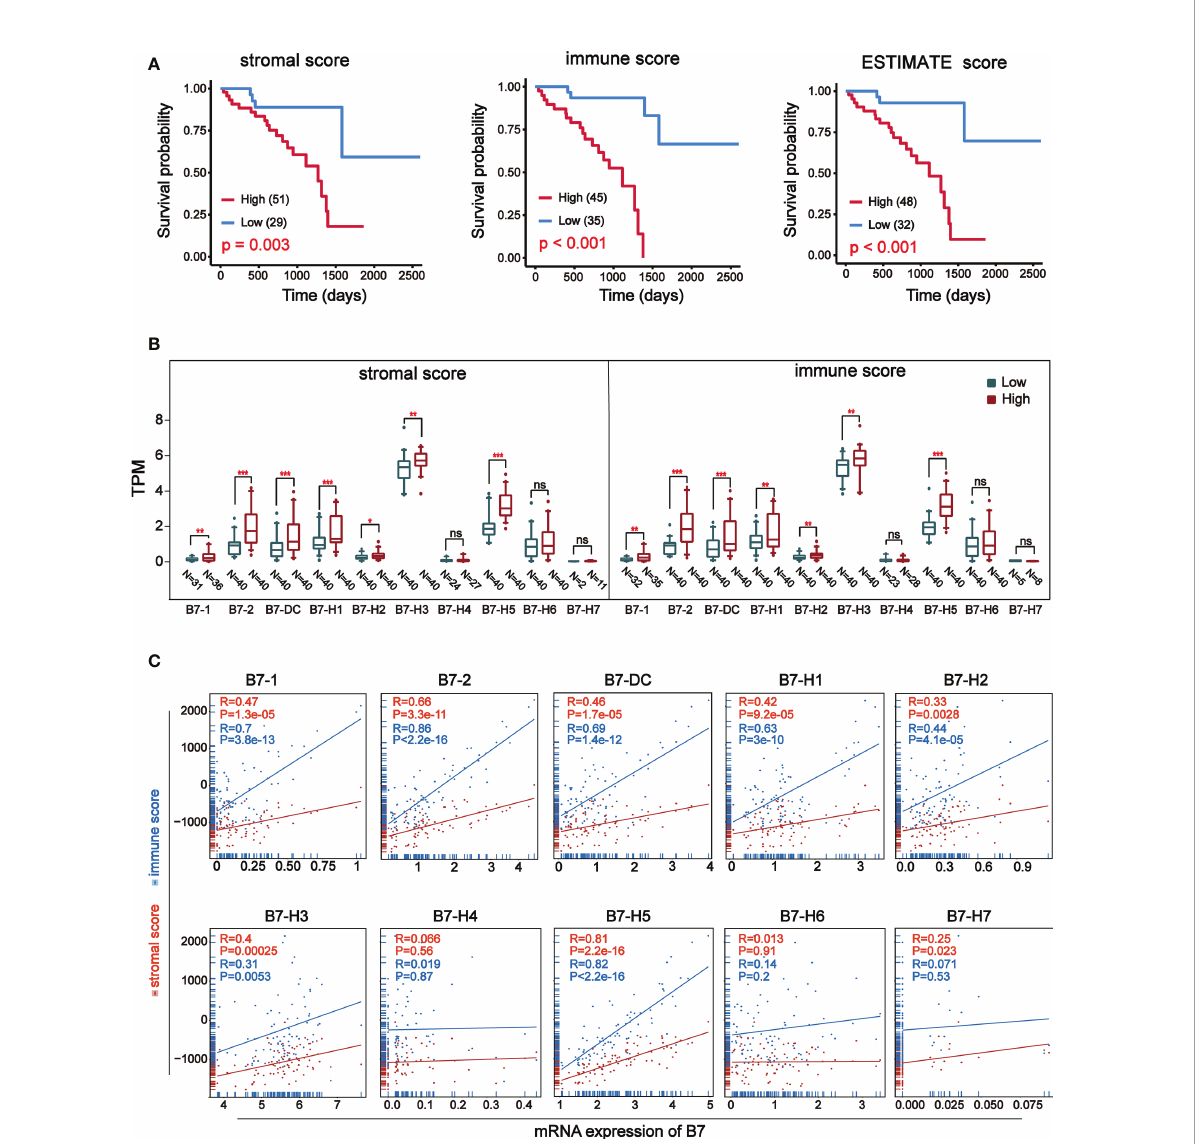
FIGURE 2 Relationship between stromal and immune score and expression of B7 family. Stromal and immune scores were obtained using expression data of UVM from the TCGA database. (A) Kaplan-Meier survival curves of ESTIMATE score. (B) The expression of B7 family was compared according to high and low score in stromal or immune score by median. The blue boxes represent low score, and the red boxes represent high score. annotation: ‘ ns ’ : none signi fi cance. (* P < 0.05**, P < 0.01, and *** P < 0.001). (C) The correlation betweenB7 expression and stromal score and immune